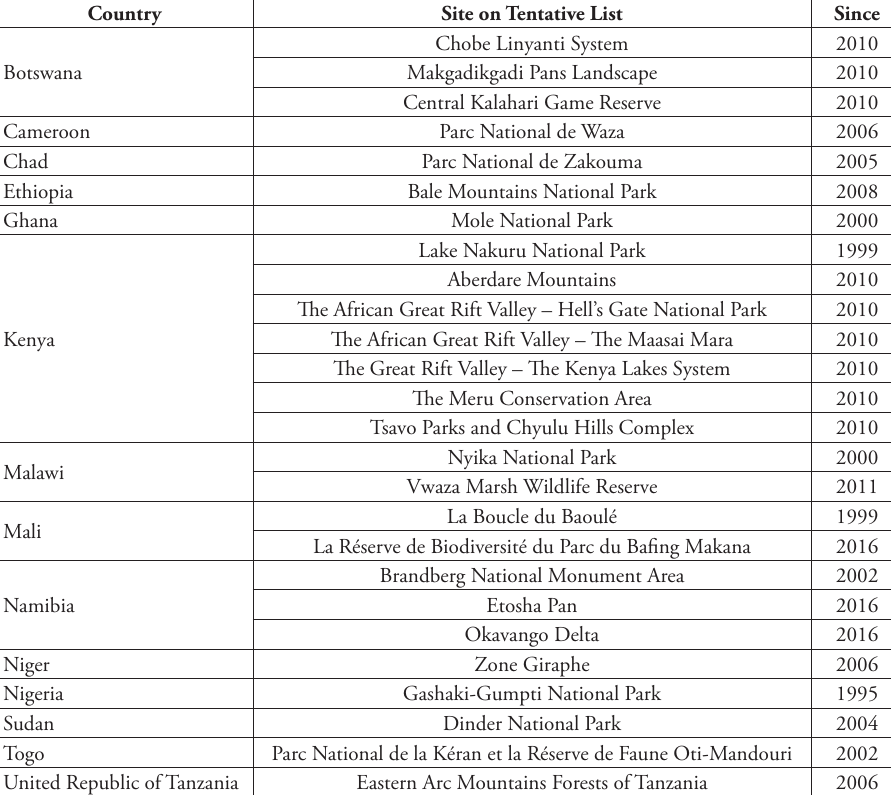
Table 5. Sites of importance to lion conservation on range states’ tentative World Heritage lists. Whereas most of these sites currently have lions, some sites have been included from which lions have disappeared in the recent past. For more detailed information on each site, see